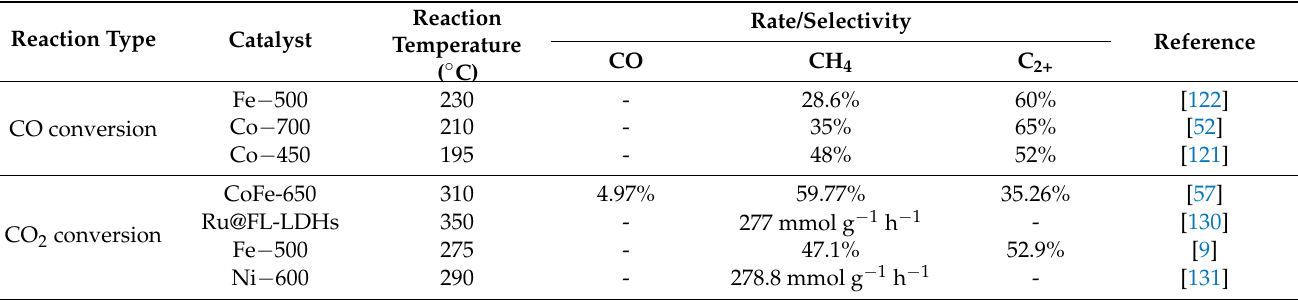
Table 2. Summary of the research on the LDH-derived materials for photothermal CO/CO 2 conversion. Reaction